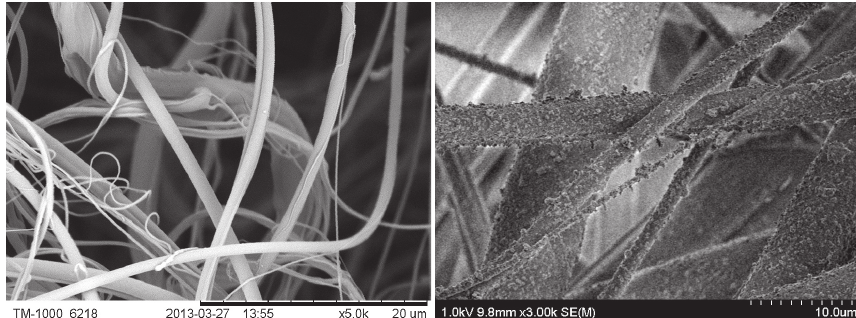
Fig. 6 Fibrous filter before (left side) and after (right side) filtration of diesel exhaust particles.